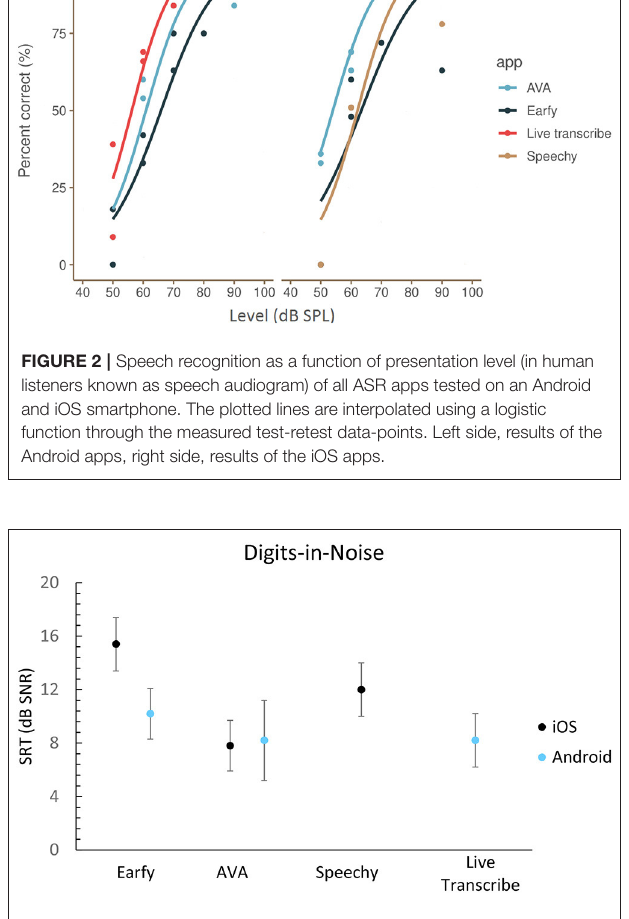
FIGURE 3 | Digit in noise results expressed in SNR per app. A lower score is better. The error bars represent the standard deviation of the response of the app within a single list of